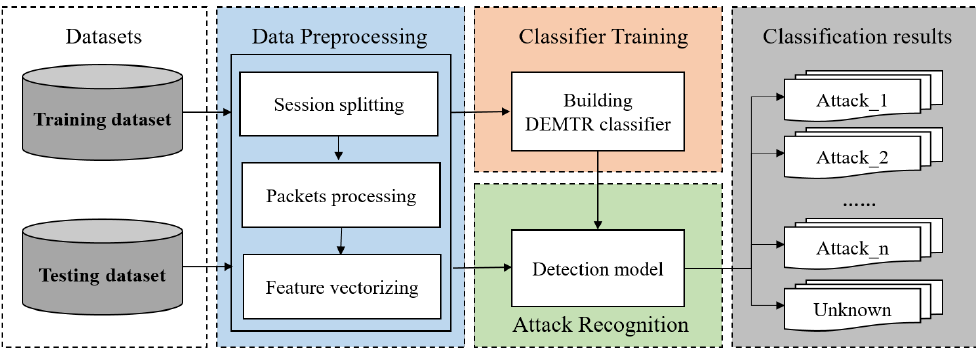
Figure 1. The framework of the proposed